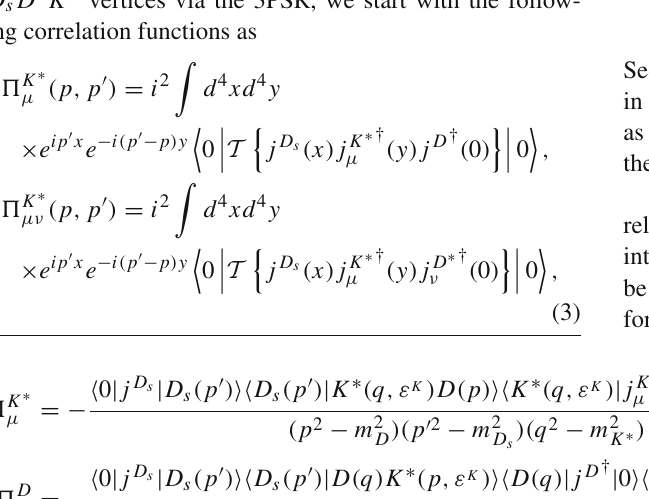
Fig. 1 Perturbative diagrams for off-shell K ∗ ( a ) and off-shell D meson ( b